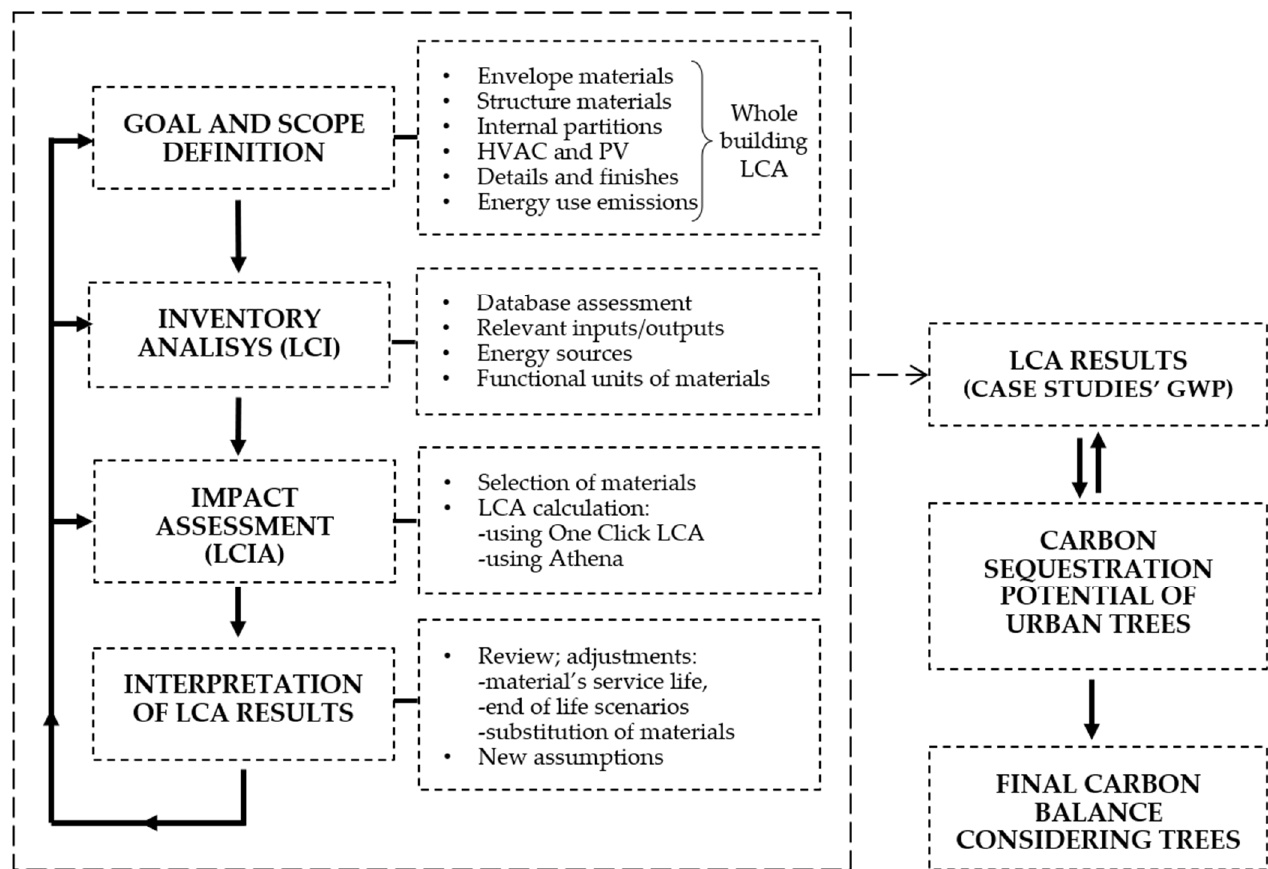
Figure 1. Research framework overview. Error! Reference source not found. shows